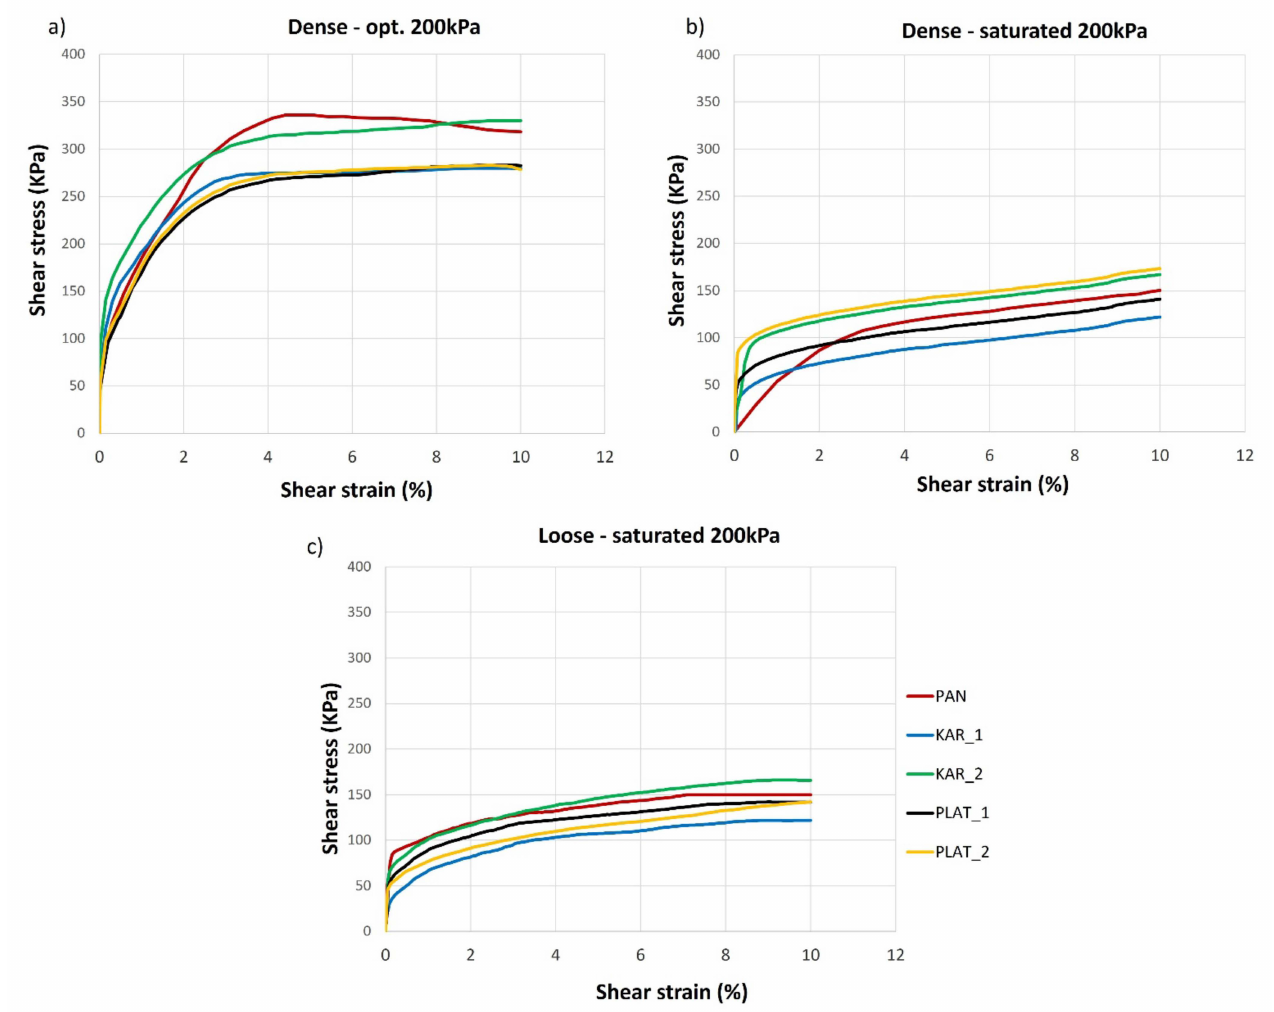
Figure 4. Shear stress—horizontal strain curves under normal loading of 200 kPa for ( a ) Dense—OPT, ( b ) Dense—saturated, and ( c ) Loose—saturated specimen